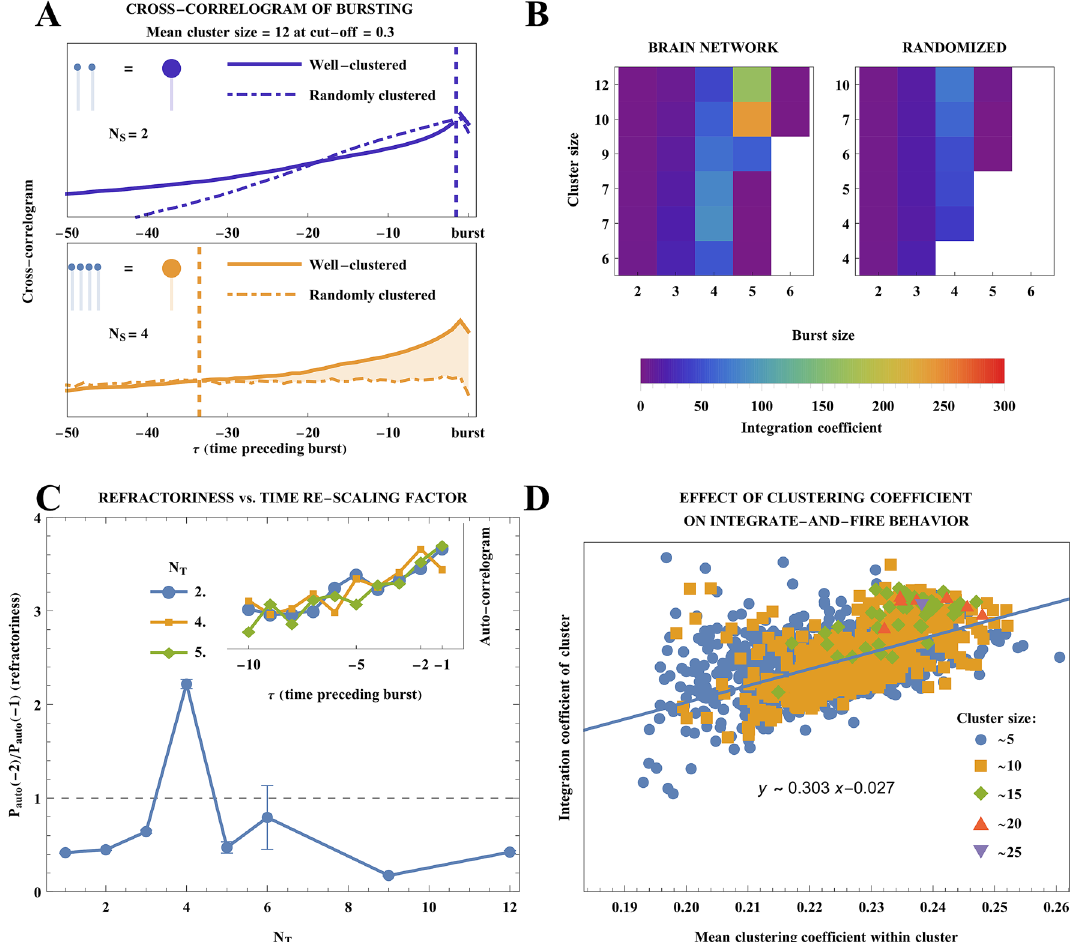
Figure 3. Ensemble-edge-weighted cross-correlogram P (τ) of cluster-spiking behavior identifies discrete scaling factors, at which integrate-and-fire behavior re-emerges in actual brains. (A) The intuition for integration coefficient (IC)—the degree, to which cross-correlogram of well-clustered brain’s ensemble-spiking activity P (τ) exceeds that of randomly clustered brain P random (τ) is indicated (shaded area) and acts to quantify the neuron- like behavior of ensemble-nodes (neuronal clusters). See Methods for definition of IC and cross-correlograms. Shown for ensemble-spikes defined as N s = 2 spikes (top sub-panel) and N s = 4 spikes (bottom sub-panel). (B) (Left) Heatmap of the Integration coefficient (IC) determines the ensemble-neuron size N N and ensemble- spike size N S used in re-scaling that best reproduces neuron-like behavior when clustered starting from a brain network. (Right) As a control, we show that the same signal integration behavior is lost when brain network is coarse-grained after a random shuffling (see “Methods” for procedure) that preserves strengths of all nodes (strength—sum of node’s edge weights). This rules out the node strength sequence of brain network as the driver of its neuron-like behavior at the coarse scale. (C) The temporal re-scaling factor N t is obtained by calculating the auto-correlogram P auto (τ) (see Methods for definition) and maximizing the ratio P auto ( − 2 )/ P auto ( − 1 ) to reveal refractory period in coarse-grained network. (D) Local clustering coefficient among nodes within an ensemble-node corresponds with its integrate-and-fire behavior. Positive dependence indicates that highly interconnected set of nodes can join into an ensemble-node with more neuron-like integration of